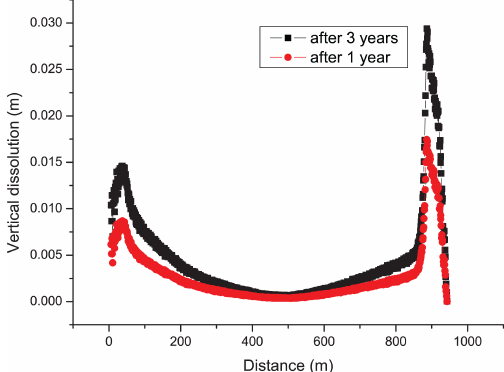
Figure 8. Amount of vertical dissolution over each element after 6months and 3years of simulation with 40m wide fault